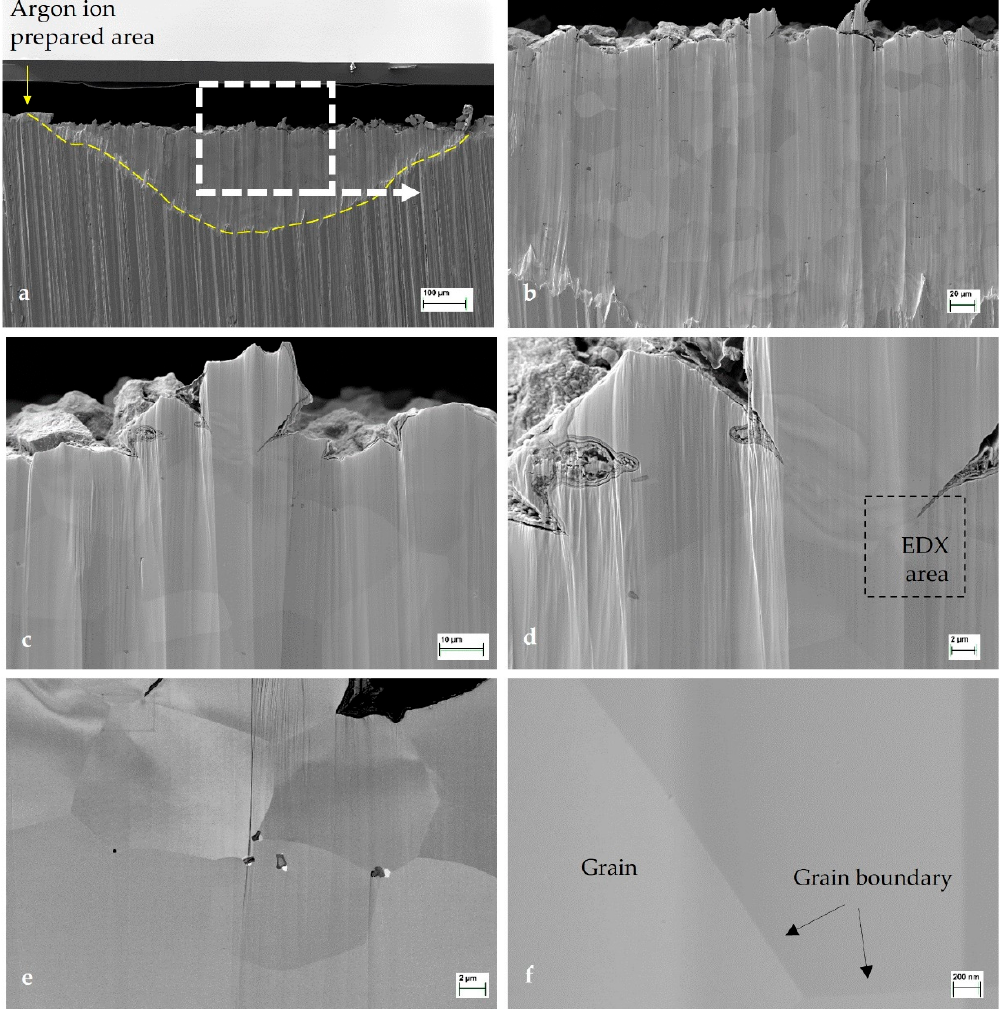
Figure 5. SEM image of corroded specimen after 100 h, 1.4509 grade ( a , b , c , d , f (SE detector), e (BS detector): different mag- nification).